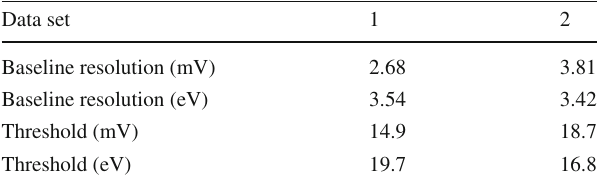
Table 1 Values for threshold and baseline resolution of the two data sets. Each value is shown in mV and in eV